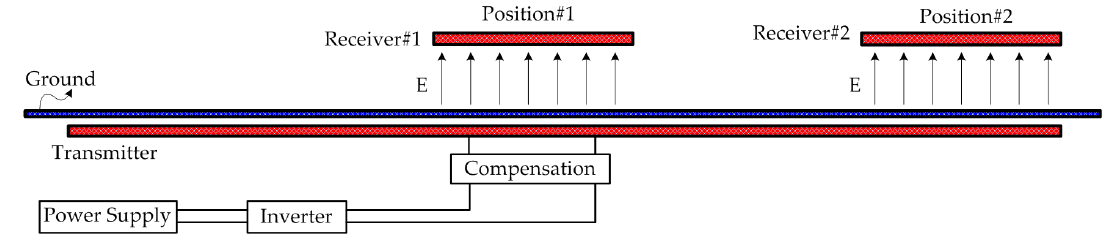
Figure 30. Structure of a dynamic CPT system.